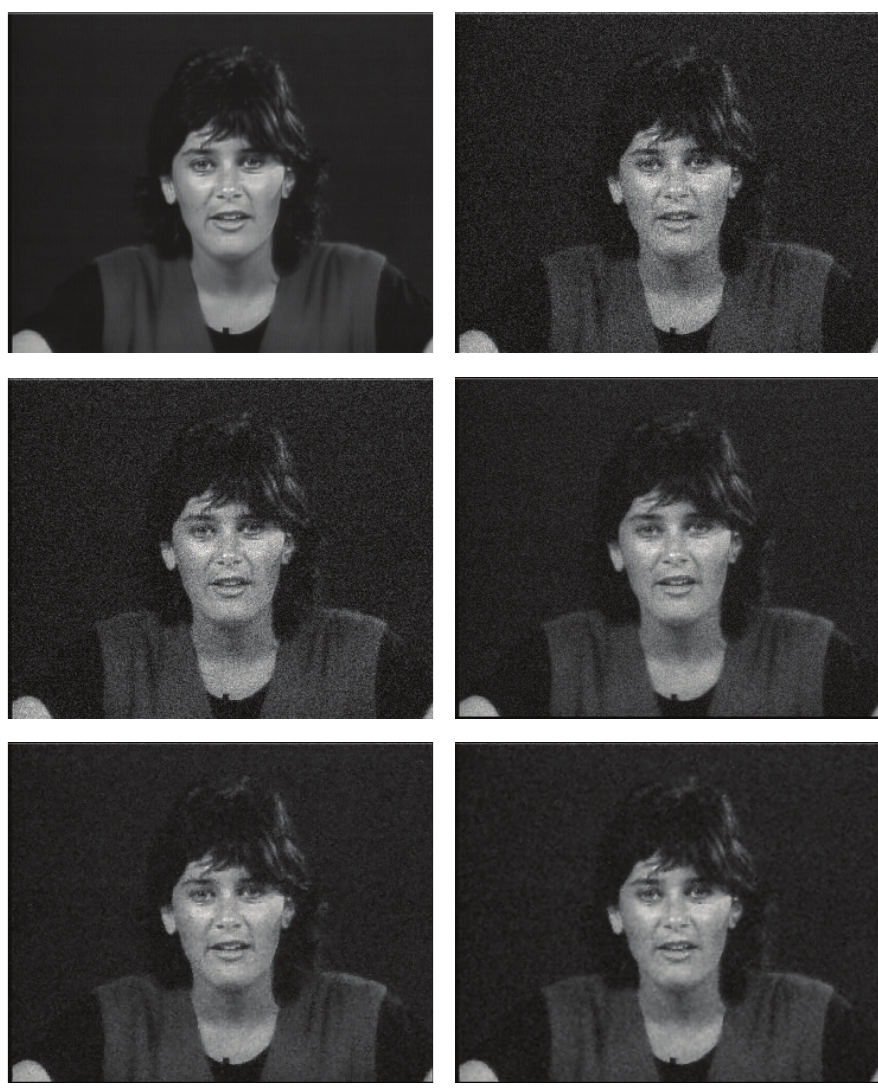
Figure 3: Visual comparison of different algorithms for frame 5 of the Miss America sequence. From left to right and from top to bottom: original frame, noisy frame ( 𝜎 𝑛 = 15 ), result of [26] algorithm, result of [27] algorithm, result of [28] algorithm, and result of the proposed